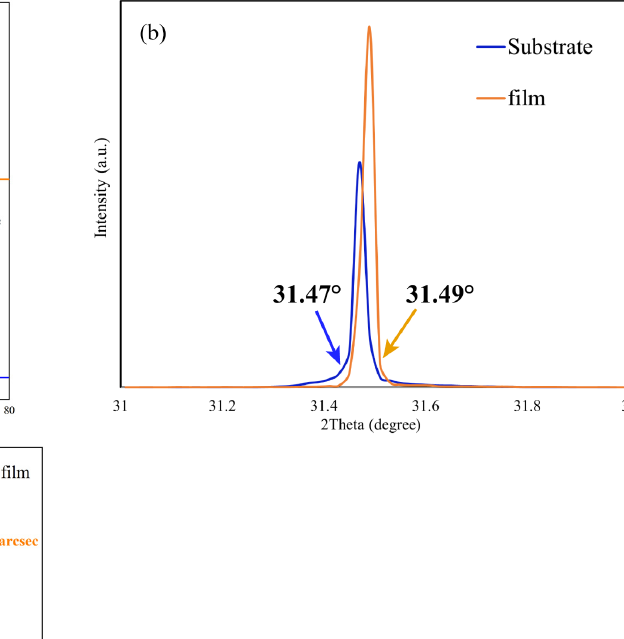
Figure 2. Raman spectra of Ga 2 O 3 film and substrate.